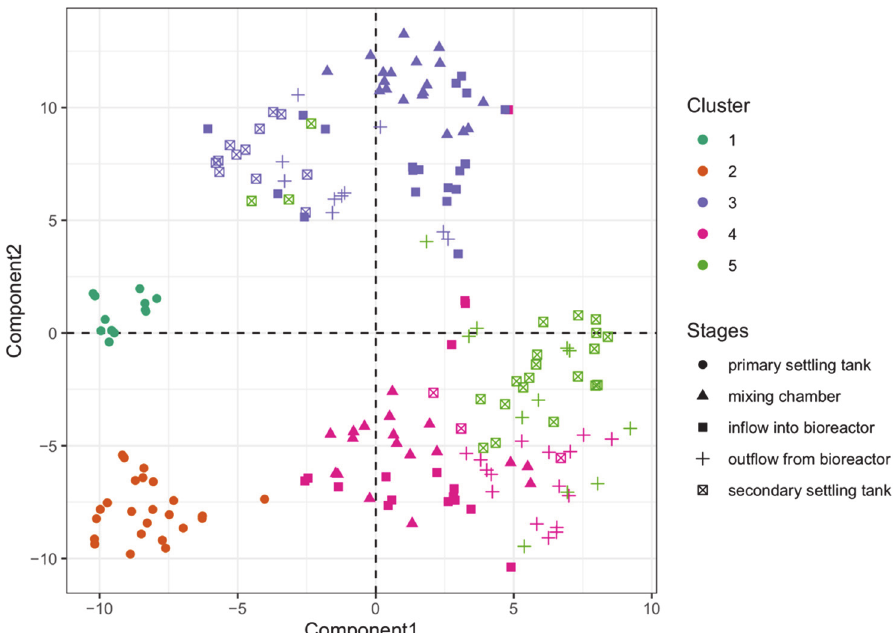
Figure 3. Silhouette plot of clusters obtained from the k ‐ medoid algorithm.